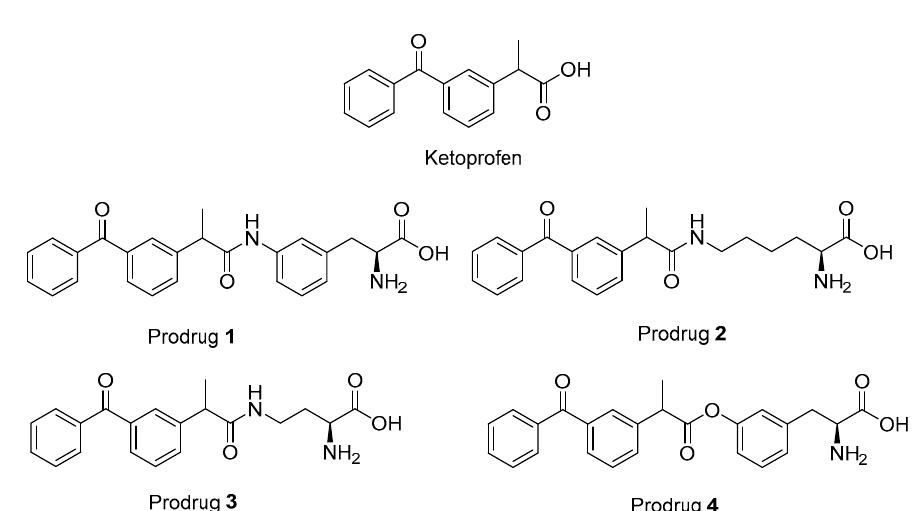
Figure 1. Structures of ketoprofen (KPF) and the studied pro-drugs 1–4.